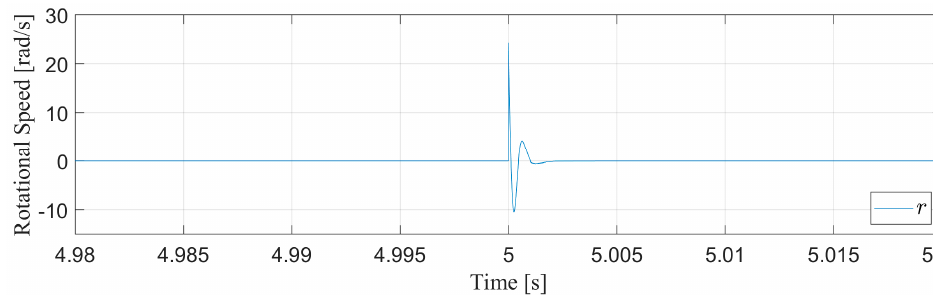
Figure 7. Filtered speed error during wind step.